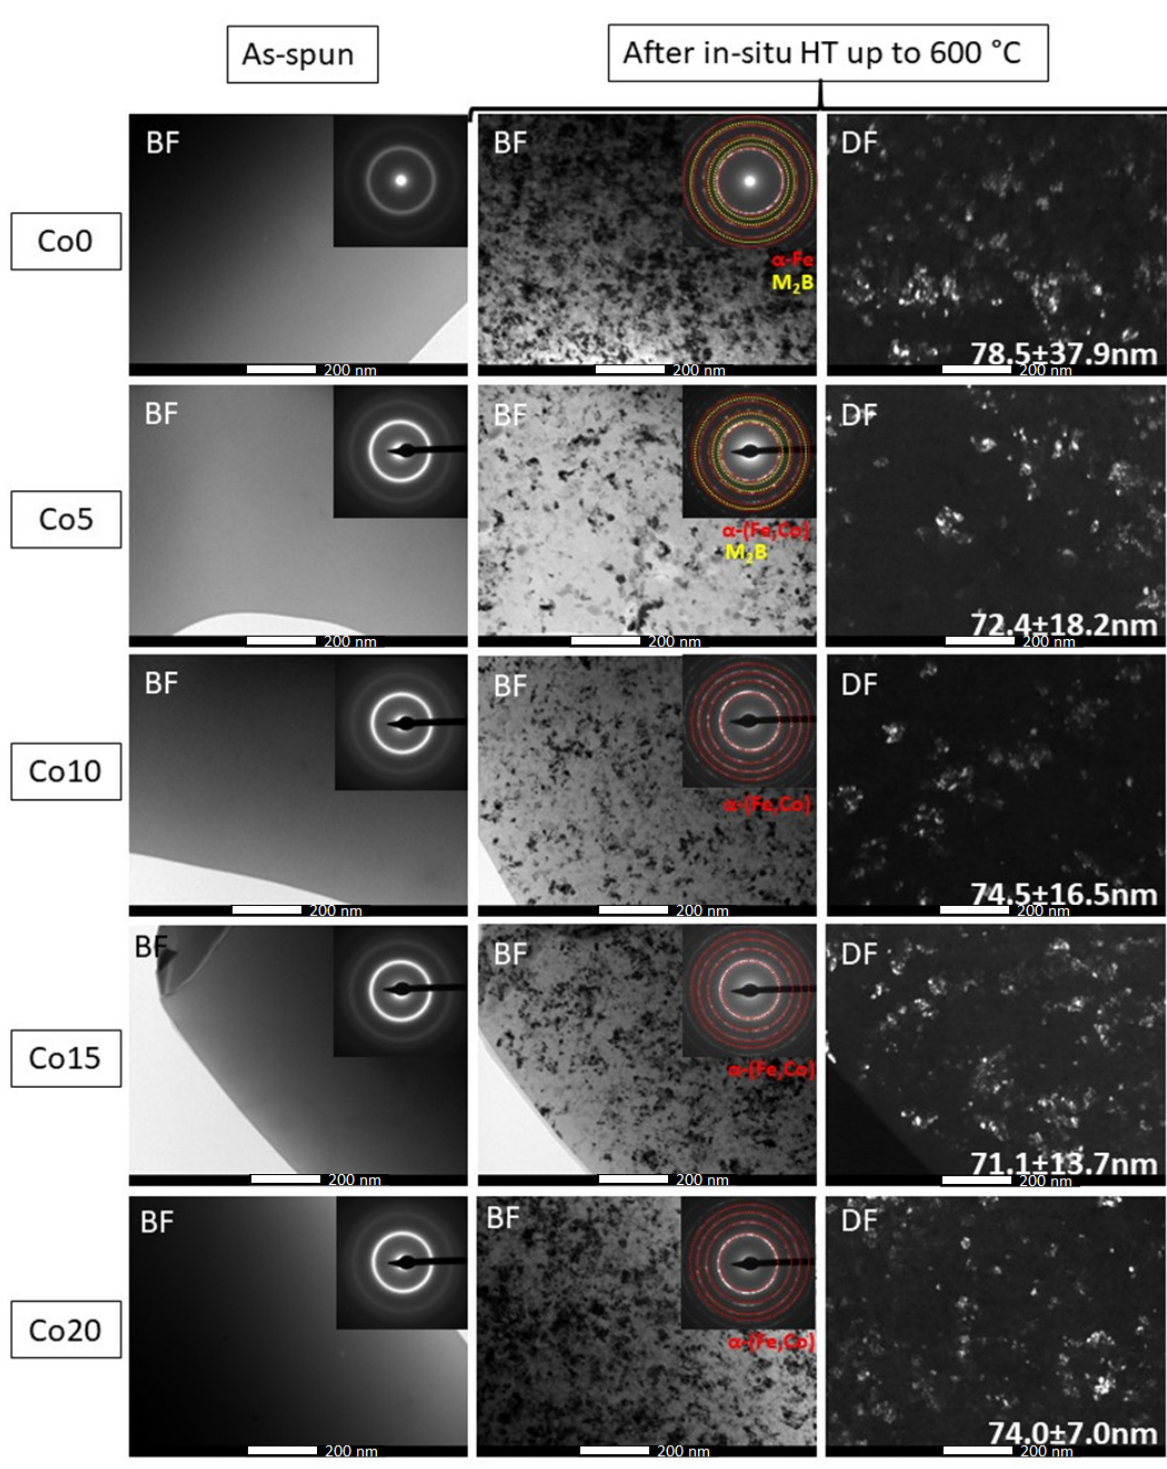
Figure 7. A set of BF, DF and SADP images for as-spun and in situ heat-treated Fe 84.5 − x Co x Nb 5 B 8.5 P 2 (x = 0, 5, 10, 15, 20 at.%) ribbons.